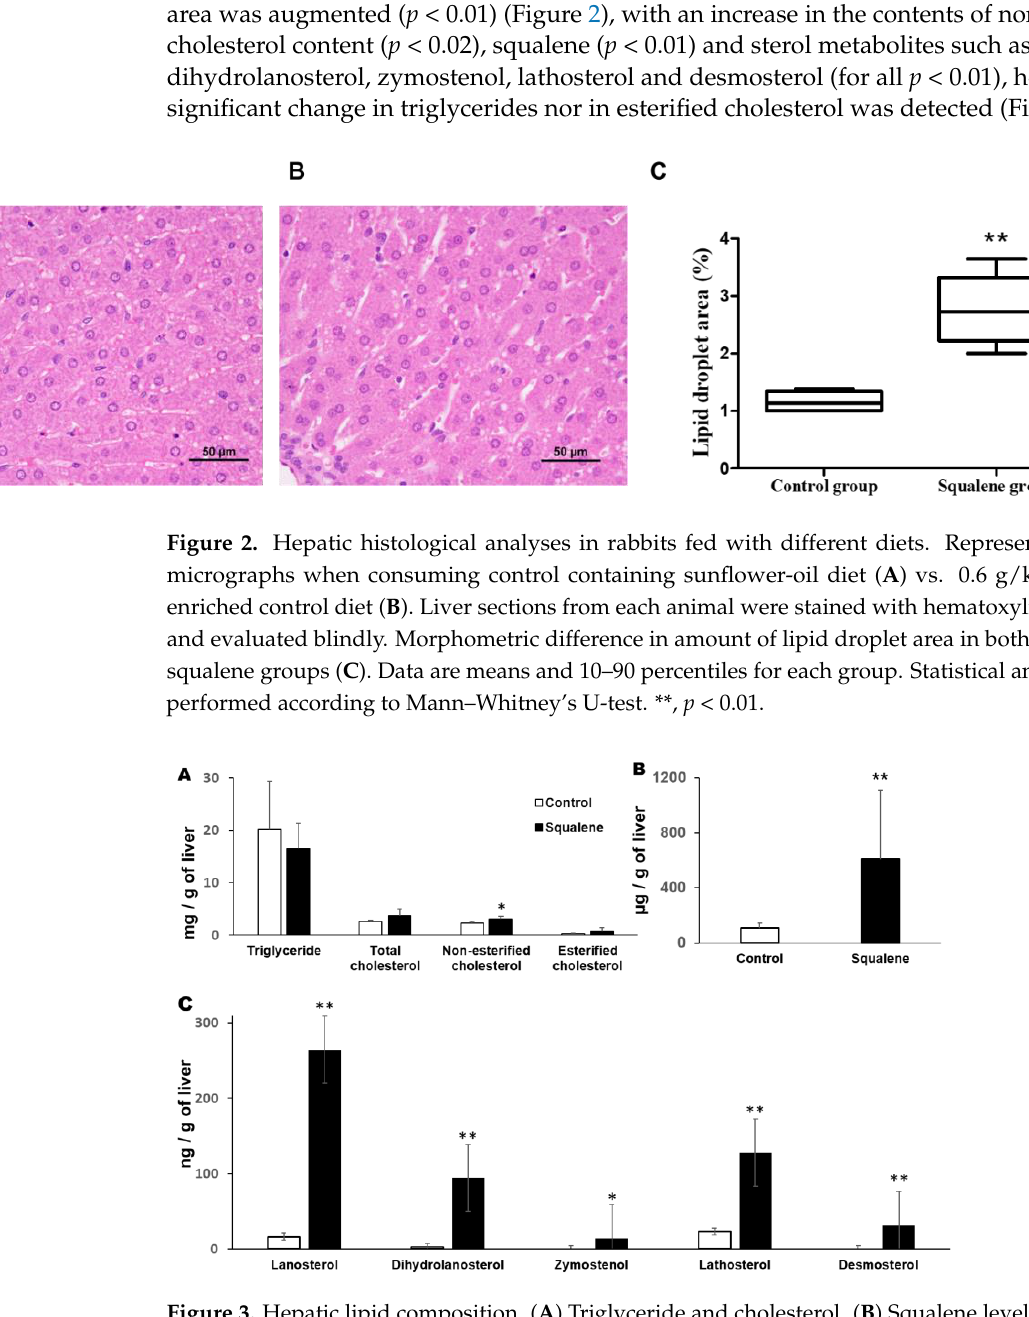
Figure 3. Hepatic lipid composition. ( A ) Triglyceride and cholesterol. ( B ) Squalene level. ( C ) Choles- terol biosynthesis intermediate sterols. Unfilled bar, control diet; filled bar, squalene-supplemented diet. Data are means ± SD. Statistical analyses were performed according to Mann–Whitney’s U-test. * p < 0.05, ** p < 0.01 vs. control.